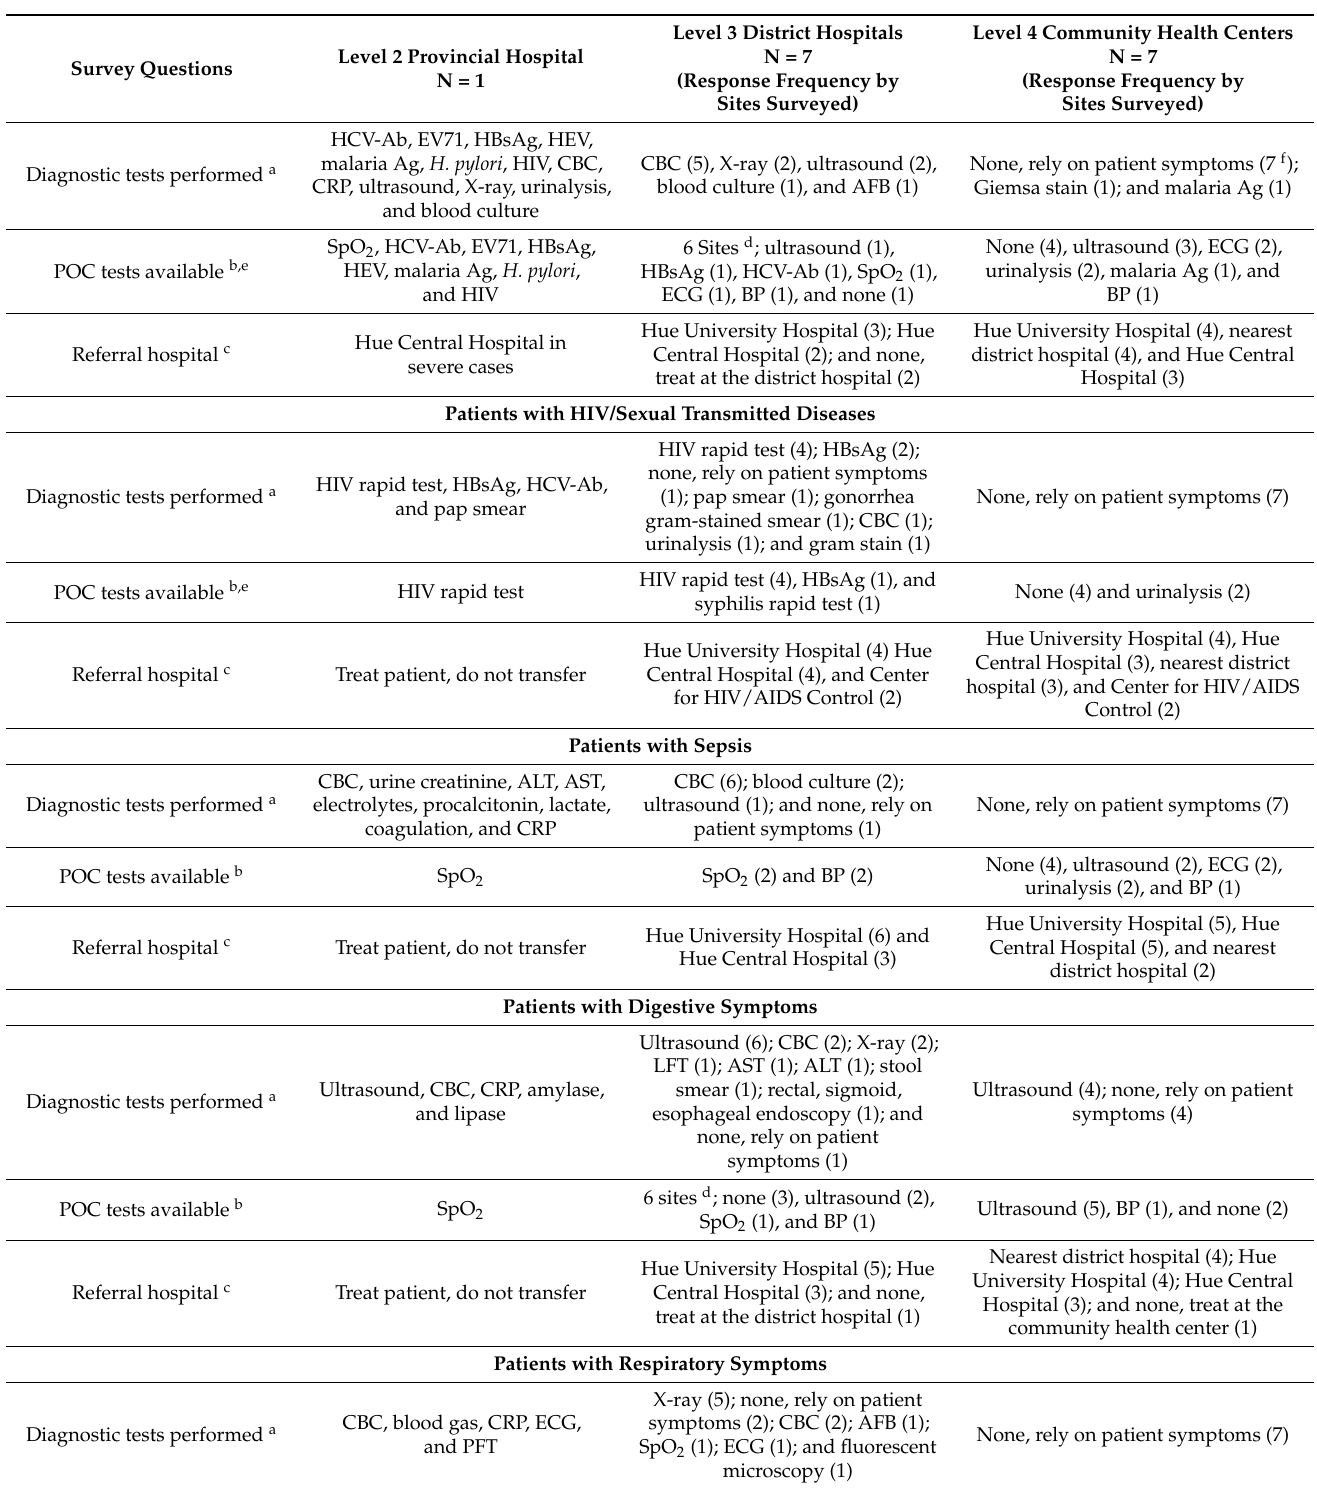
Table 2. Diagnostic test utilization, POC test availability, and referral sites for patients with infectious